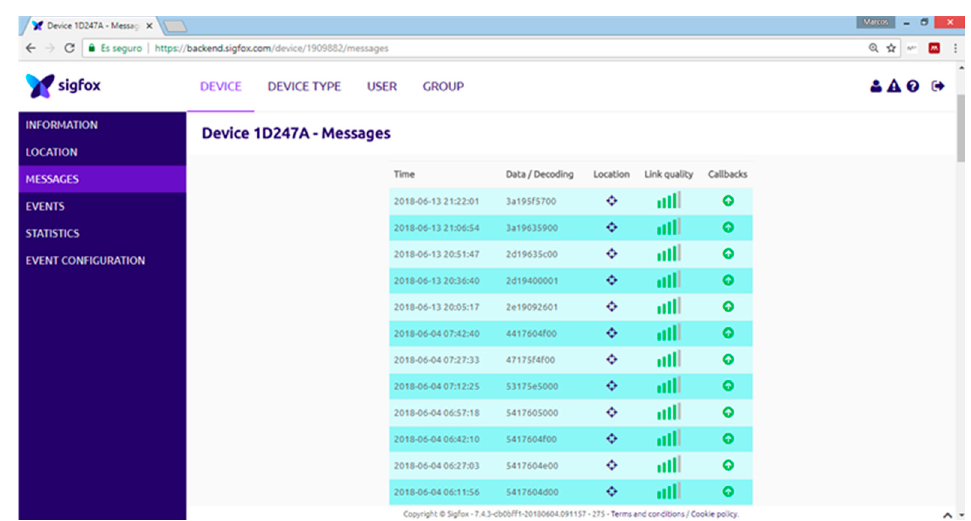
Figure 18. Messages sent in SIGFOX backend. Source: [29].